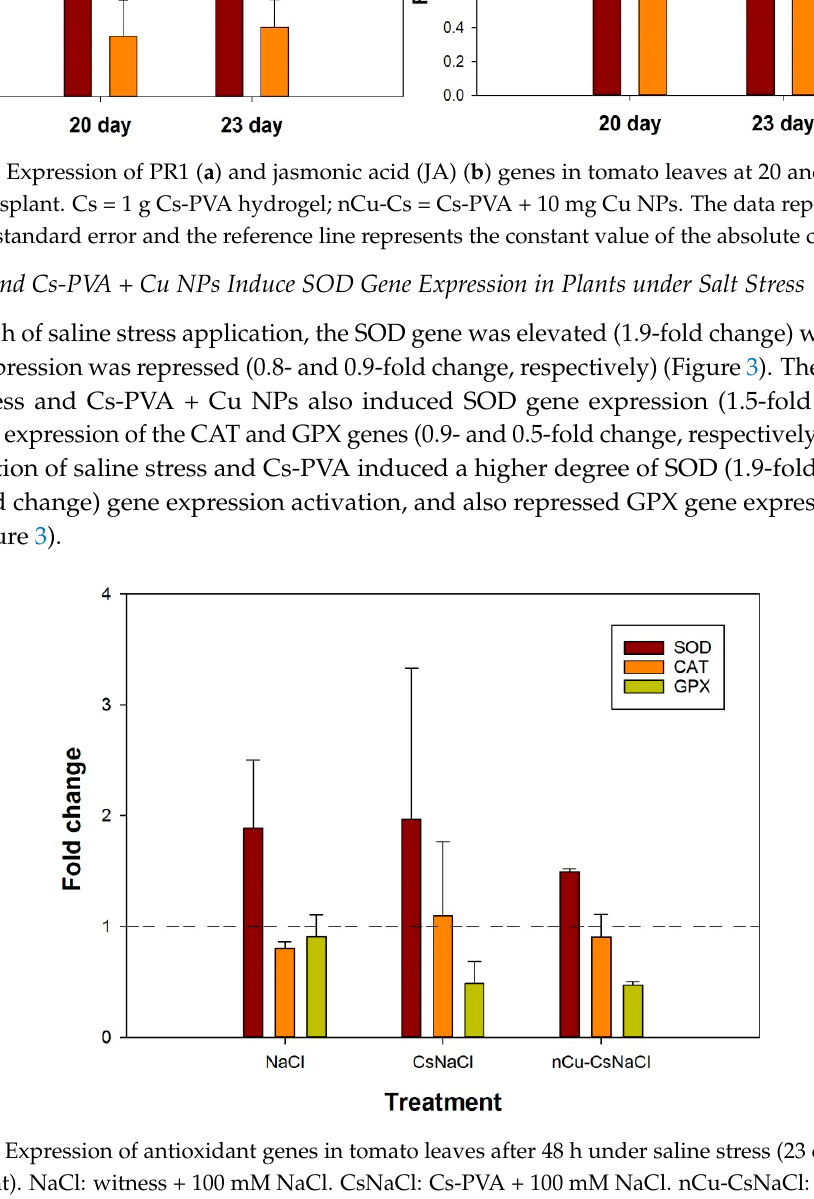
Figure 3. Expression of antioxidant genes in tomato leaves after 48 h under saline stress (23 days after transplant). NaCl: witness + 100 mM NaCl. CsNaCl: Cs-PVA + 100 mM NaCl. nCu-CsNaCl: Cs-PVA + 10 mg Cu NPs + 100 mM NaCl. The data represent the mean ± standard error and the reference line represents the constant value of the absolute control.